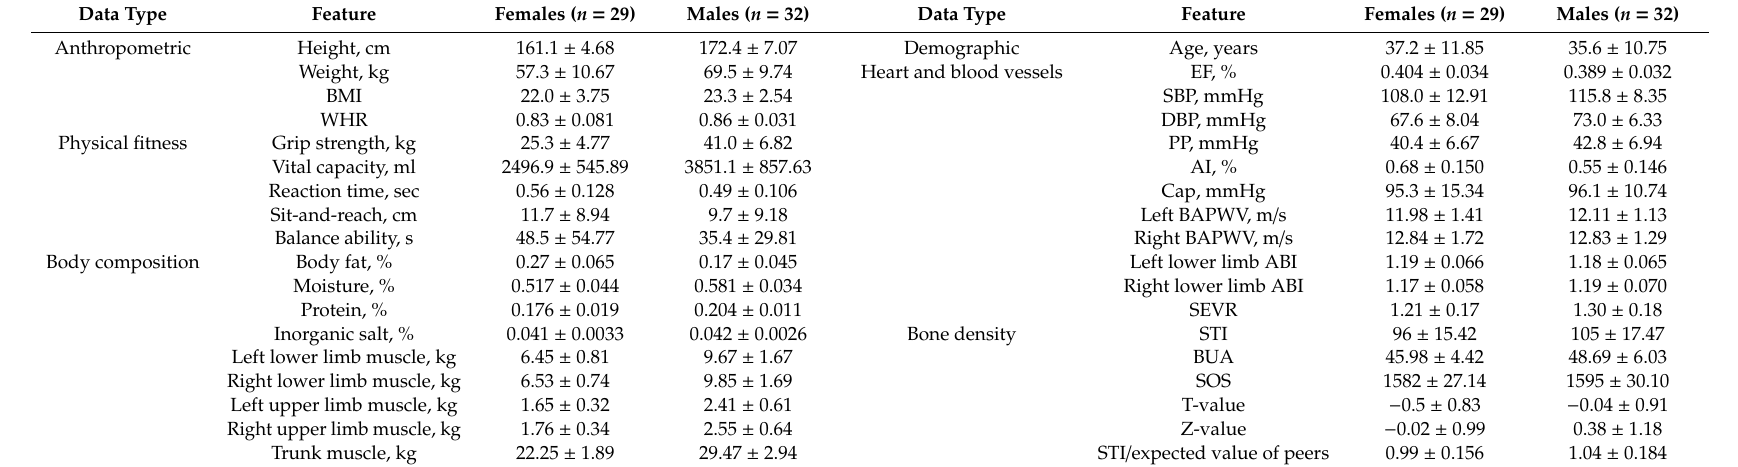
Table 1. Static human body data for the participants according to sex. Values refer to mean ± standard deviation